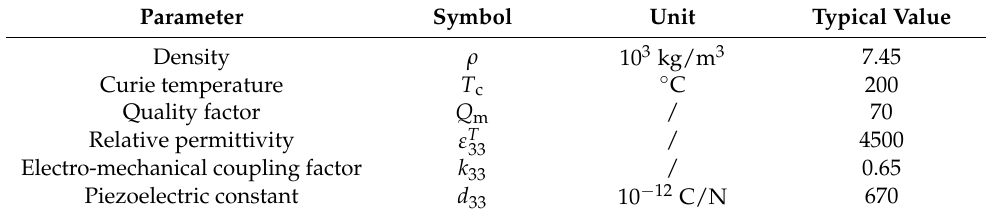
Table 1. Typical material properties of